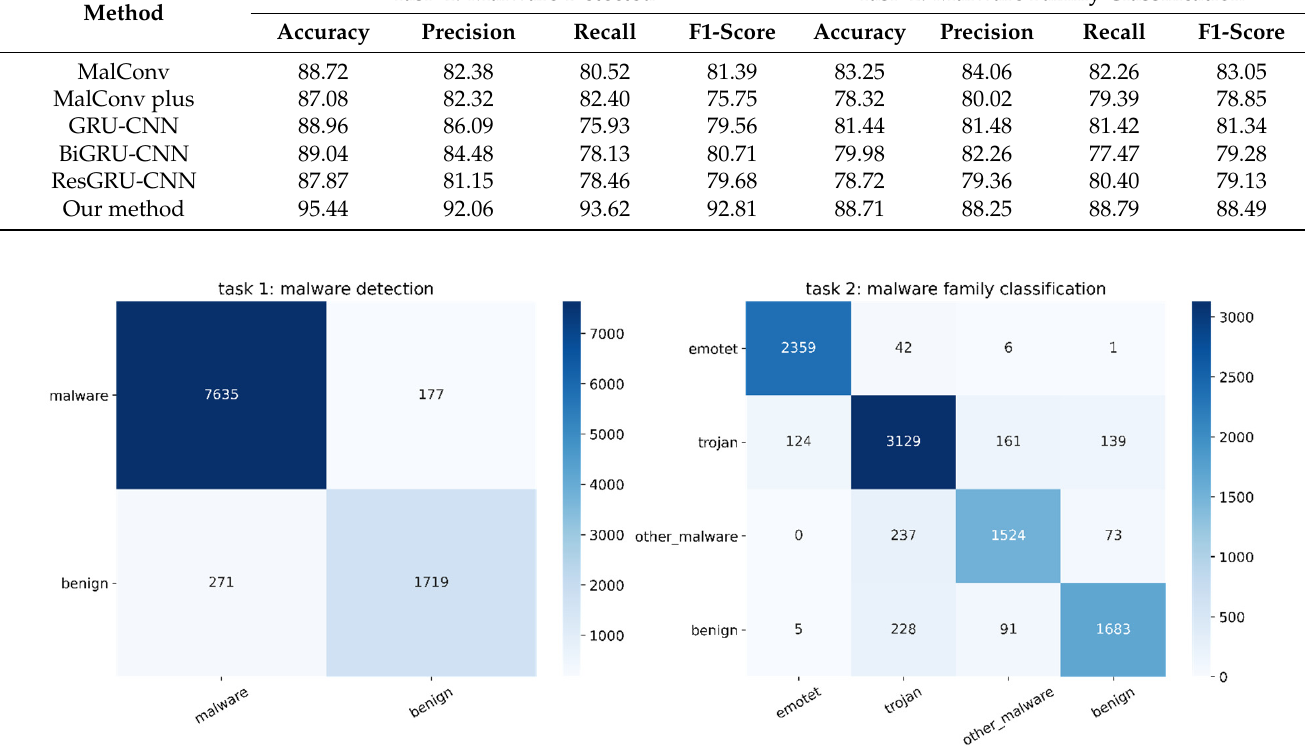
Figure 8. Confusion matrix for tasks of malware detection and malware family classification.